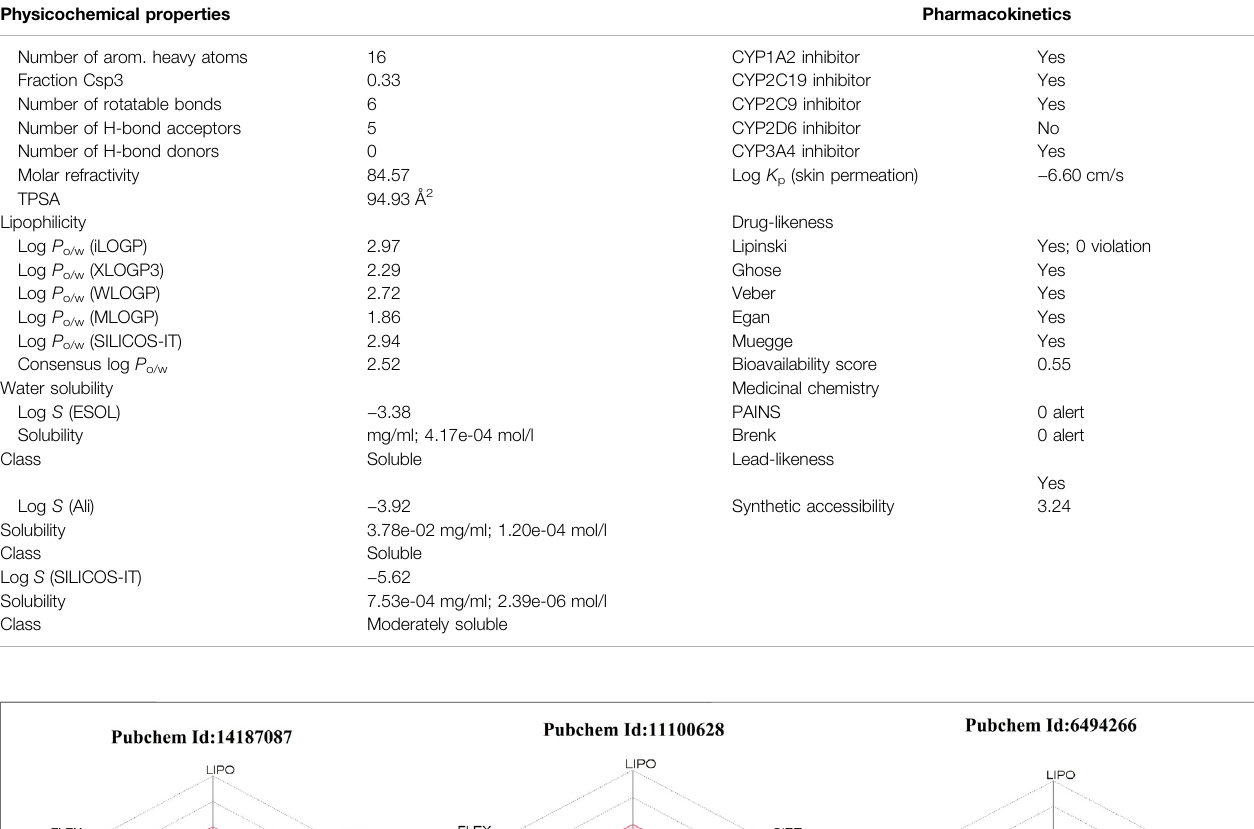
Number of arom. heavy atoms